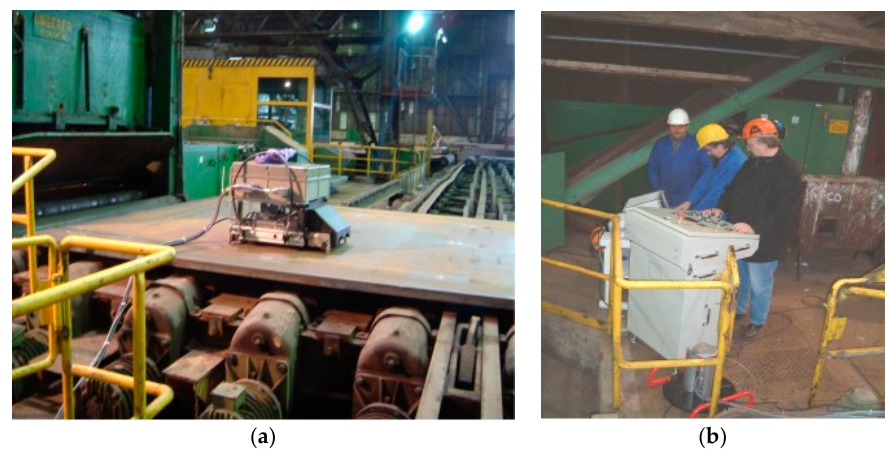
Figure 15. Remote application of the 3MA system in the roller conveyor line of a steel plant: ( a ) 3MA inspection trolley and ( b ) remote control desk.